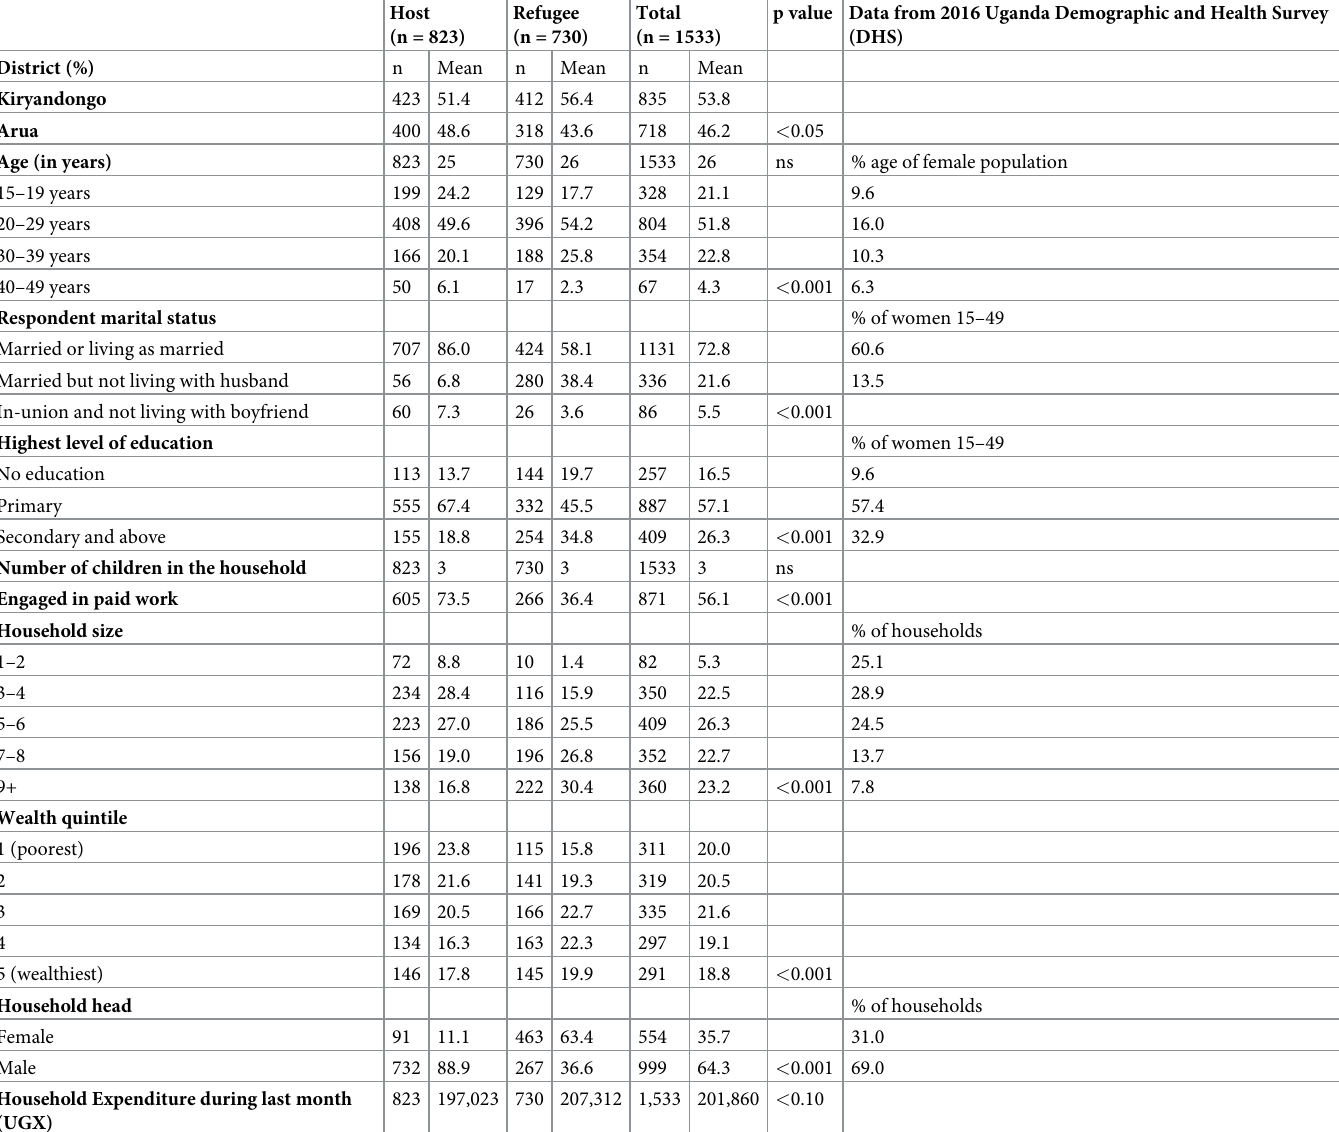
Table 3. Respondent and household characteristics from the cross-sectional survey.